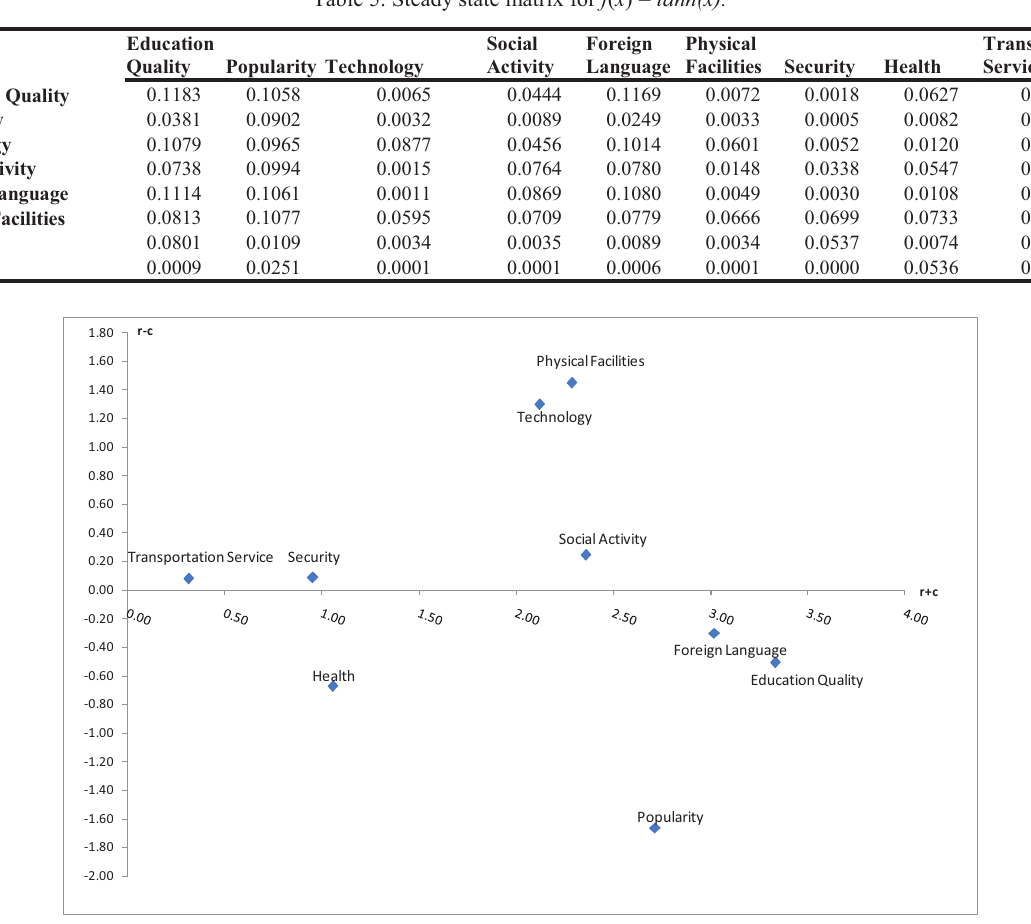
Fig. 2 Cause and effect diagram of main